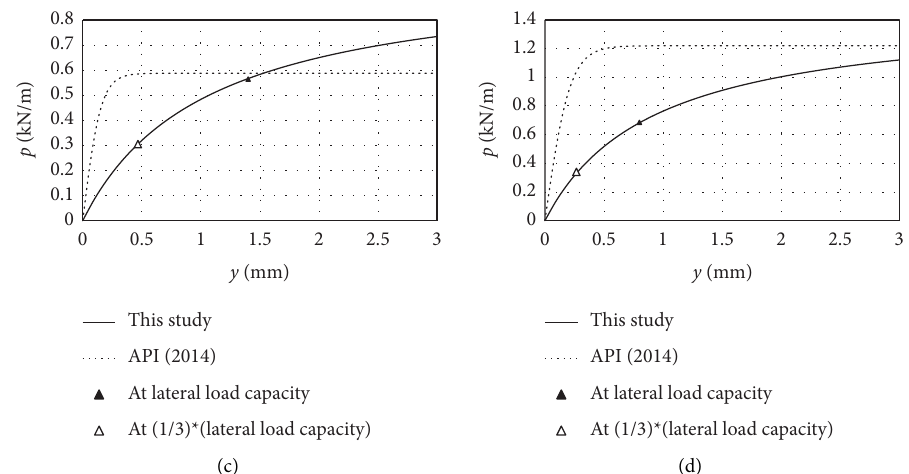
Figure 5: Comparison between experimental static p - y curves and API p - y curves (relative density of 40%): (a) 1 D , (b) 2 D , (c) 4 D , and (d) 6 D .